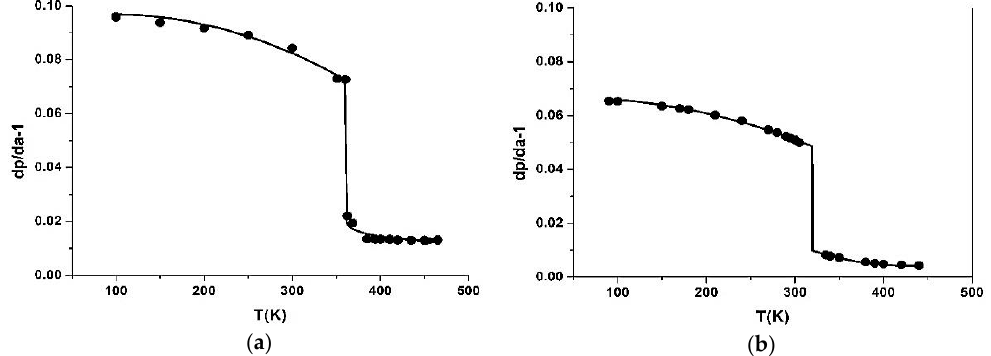
Figure 5. The δ ( T ) = dp/da − 1 index traces for ( a ) MnFeP 0.5 Si 0.5 and ( b ) Mn 0.7 Fe 1.3 P 0.65 Si 0.35.